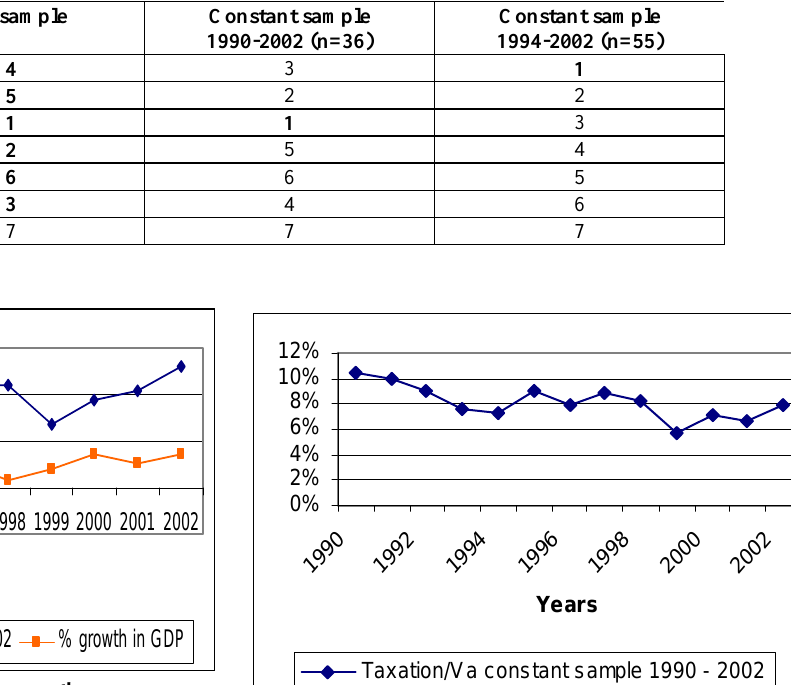
Figure 1: Retention/VA and % GDP growth per year